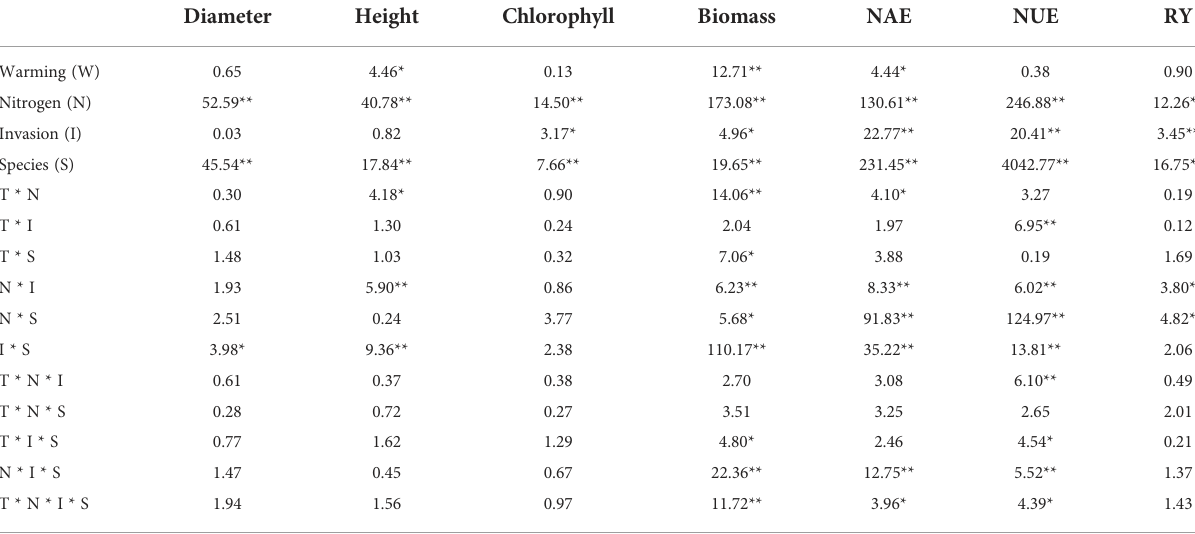
TABLE 1 The effects of warming (W), N addition (N), invasion level (I), species (S), and their interactions on phenotypic traits. Diameter Height